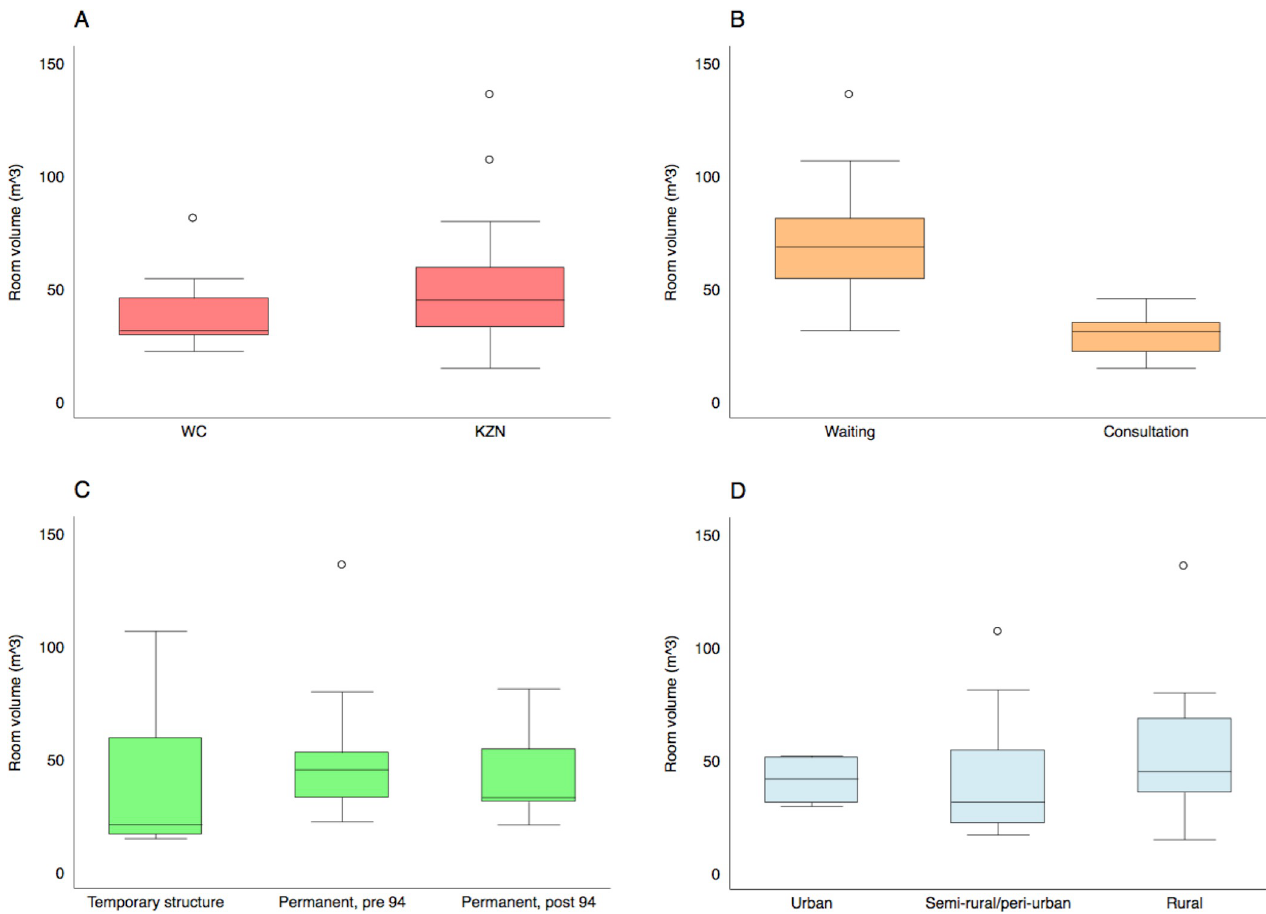
Fig 3. Box and whisker plots describing the distribution of room volumes in the clinical spaces where we conducted tracer gas release experiments. Results are disaggregated by province (Fig 3A), room type (Fig 3B), the age of the building (Fig 3C), and clinic location (Fig 3D). Here, the boxes mark the 25 th percentile, the 50 th percentile (median) and the 75 th percentile, with the whiskers marking the upper and lower adjacent